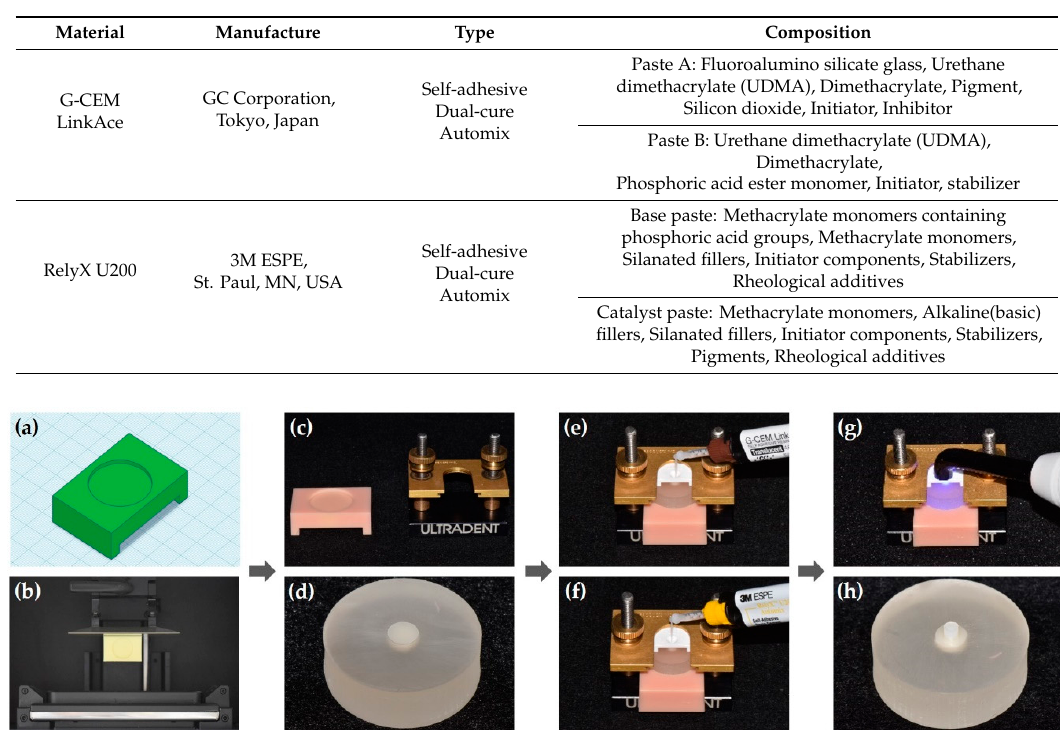
Table 2. Characteristics of two types of self-adhesive resin cement used in the SBS test.